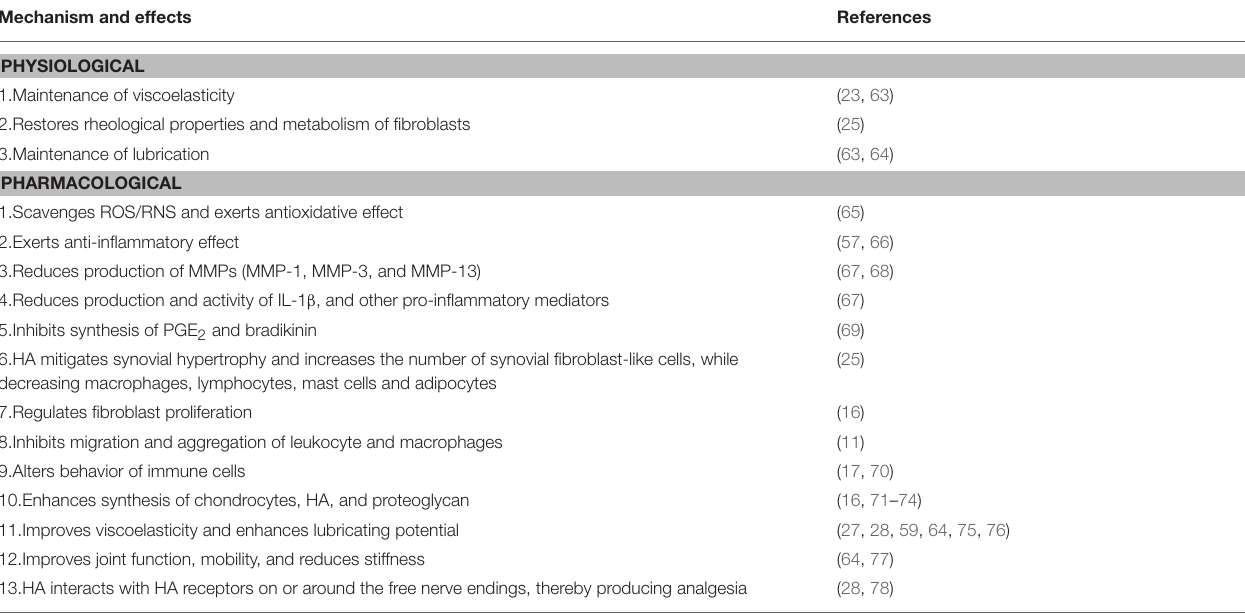
TABLE 1 | Physiological and pharmacological mechanisms and effects of HA in synovial fluid. Mechanism and